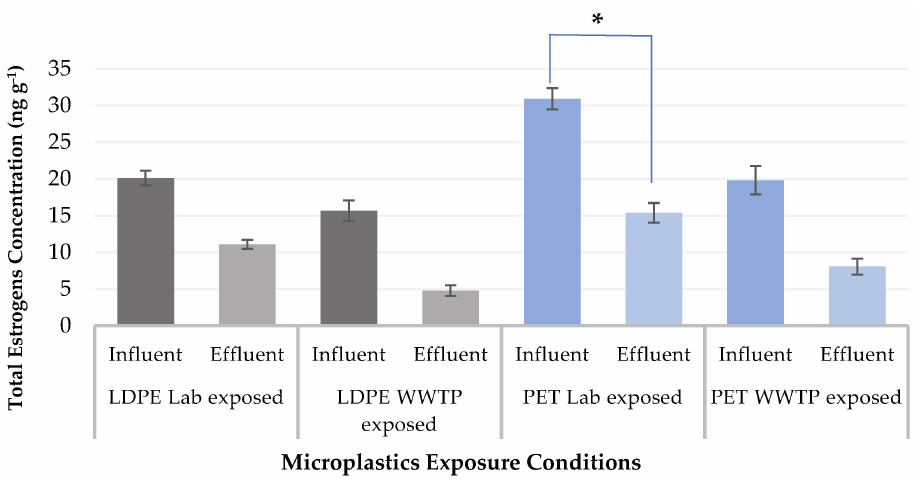
Figure 1. Total estrogen concentrations (ng g − 1 ) in WWTP and laboratory exposure settings. Signifi- cant differences were detected with a paired t -test (* p < 0.05). Gray-coloured bars represent LDPE MPs and blue-coloured bars represent PET MPs.